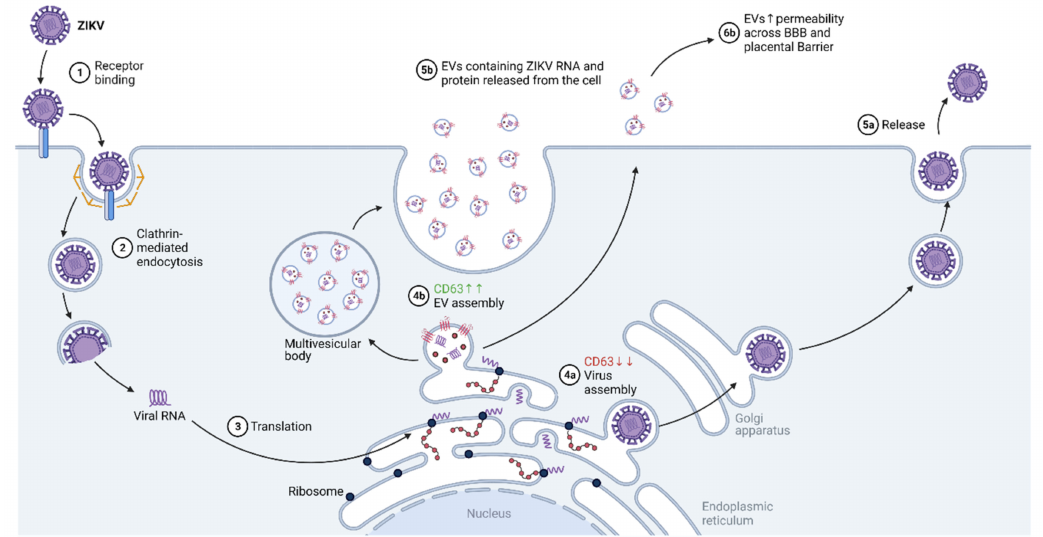
Figure 3. Diagram showing the contribution of tetraspanins in the ZIKV replication cycle. When the CD63 expression level is high, EV biosynthesis and release are enhanced. Conversely, when the CD63 expression level is low, ZIKV replication favors the formation of viral progeny. Abbreviations: ZIKV, Zika virus; BBB, blood–brain barrier; CD63, cluster of differentiation